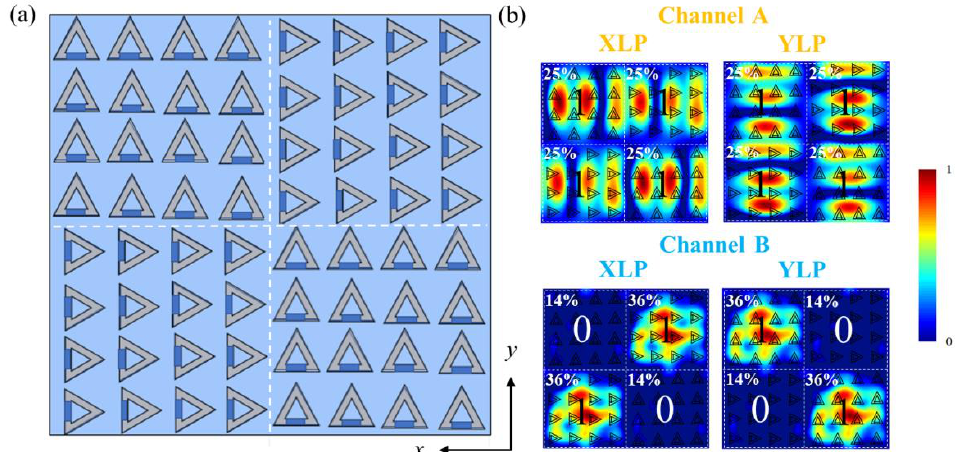
Figure 6. ( a ) Scheme of programmable metasurface; ( b ) magnetic field distributions of two channels under incident light with X- polarization and Y- polarization. The percentages represent the imaging efficiencies of the generated images.